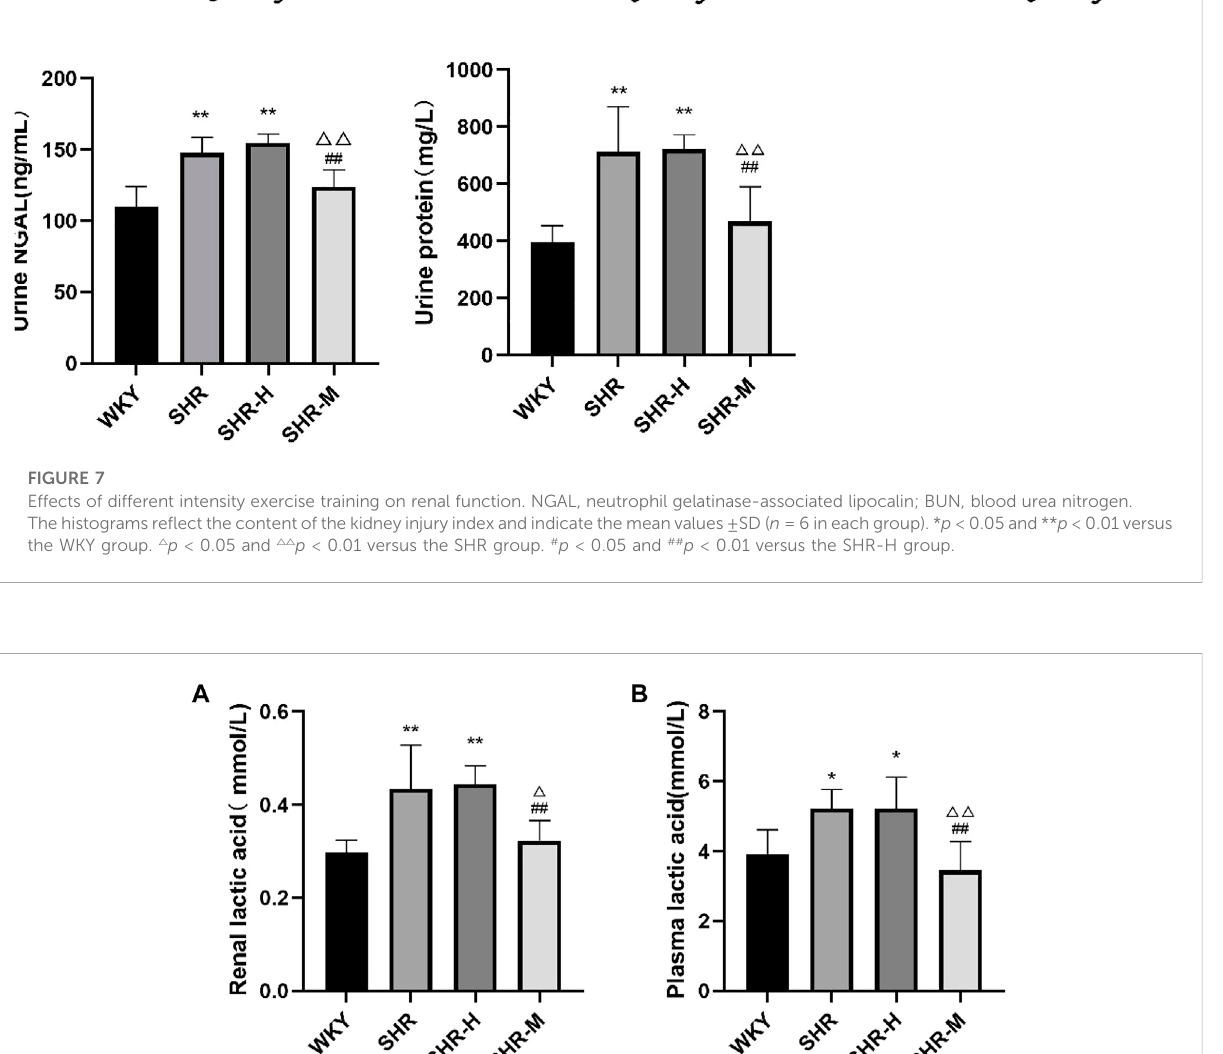
Effects of different intensity exercise training on lactic acid. (A,B) Histograms re fl ect the concentration of lactic acid and indicate mean values ±SD ( n =6in eachgroup).* p < 0.05 and ** p < 0.01 versustheWKY group. △ p < 0.05and △△ p < 0.01 versustheSHR group. # p < 0.05and ## p < 0.01 versus the SHR-H